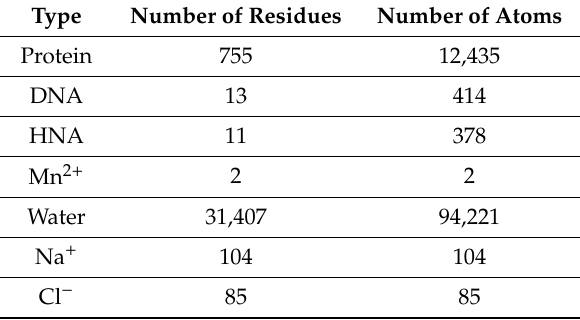
Table 1. Initial system composition for the Molecular Dynamics run, including hydrogen